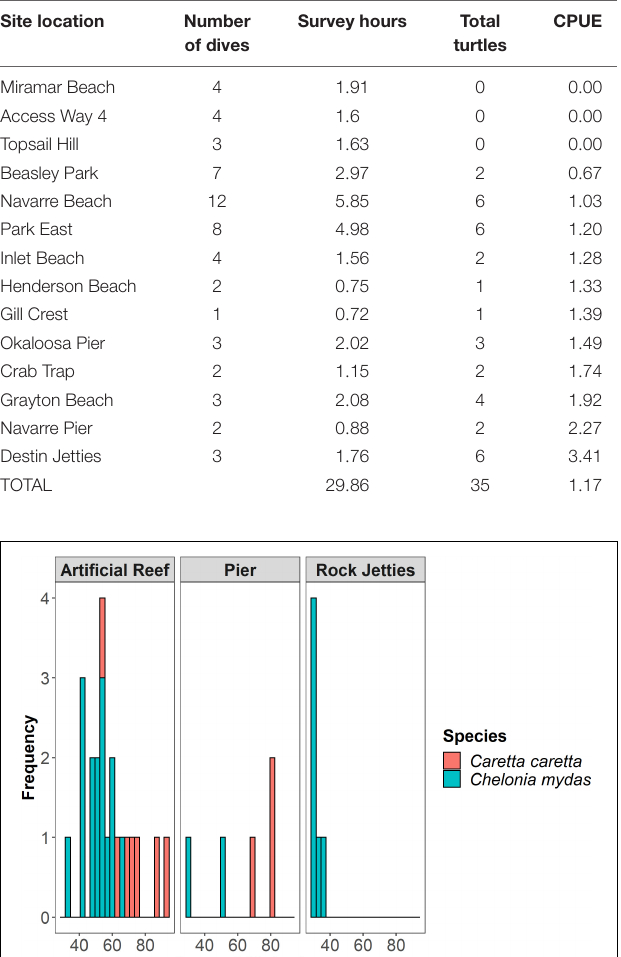
TABLE 1 | Relative filming catch per unit effort (CPUE) of all species of sea turtles (n) per survey hour among locations during snorkel surveys. CPUE calculation includes Kemp’s ridleys.